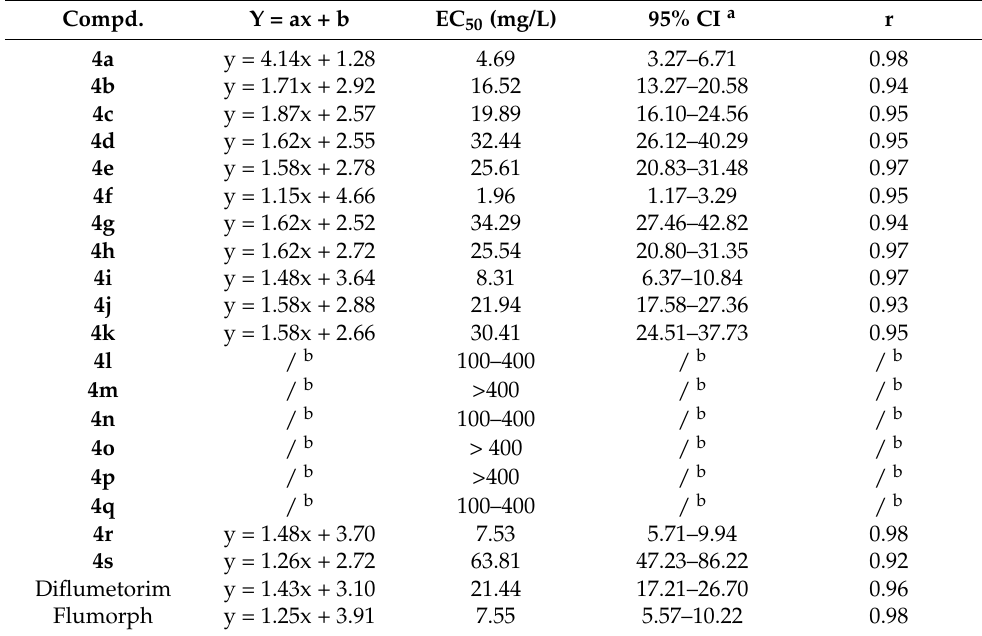
Table 2. EC 50 values of target compounds 4a ~ 4s against cucumber downy mildew in green